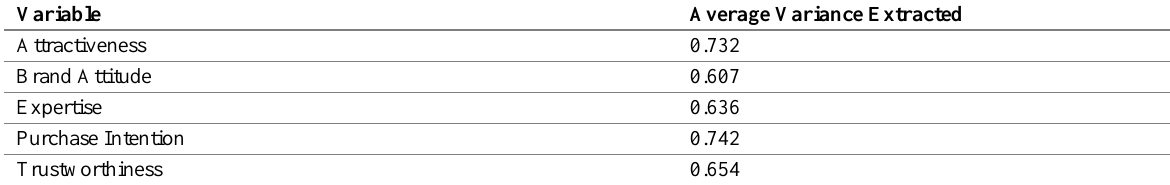
Table 1: Average Variance Extracted (AVE)